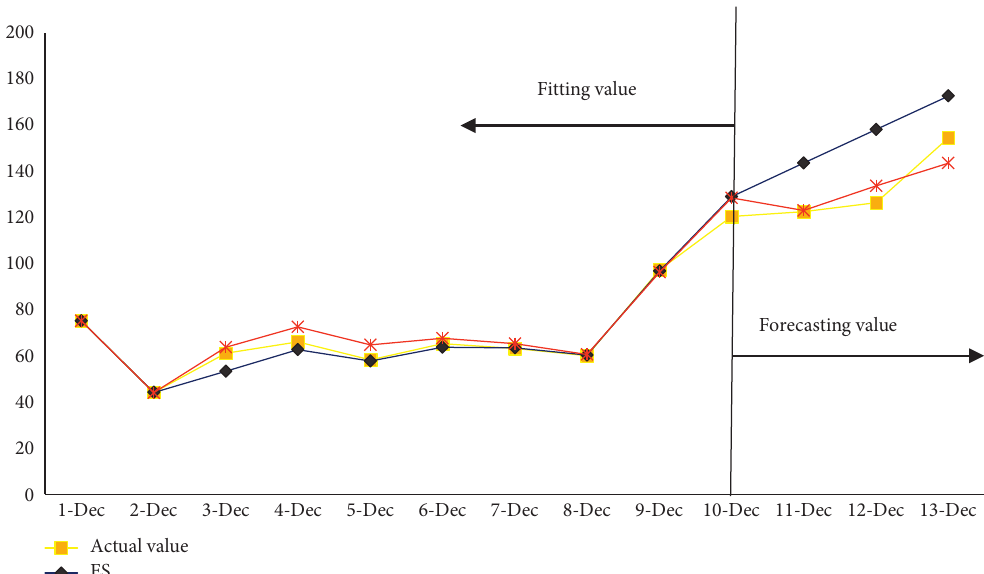
Figure 5: Compared forecasting results between hybrid model and ES in PM